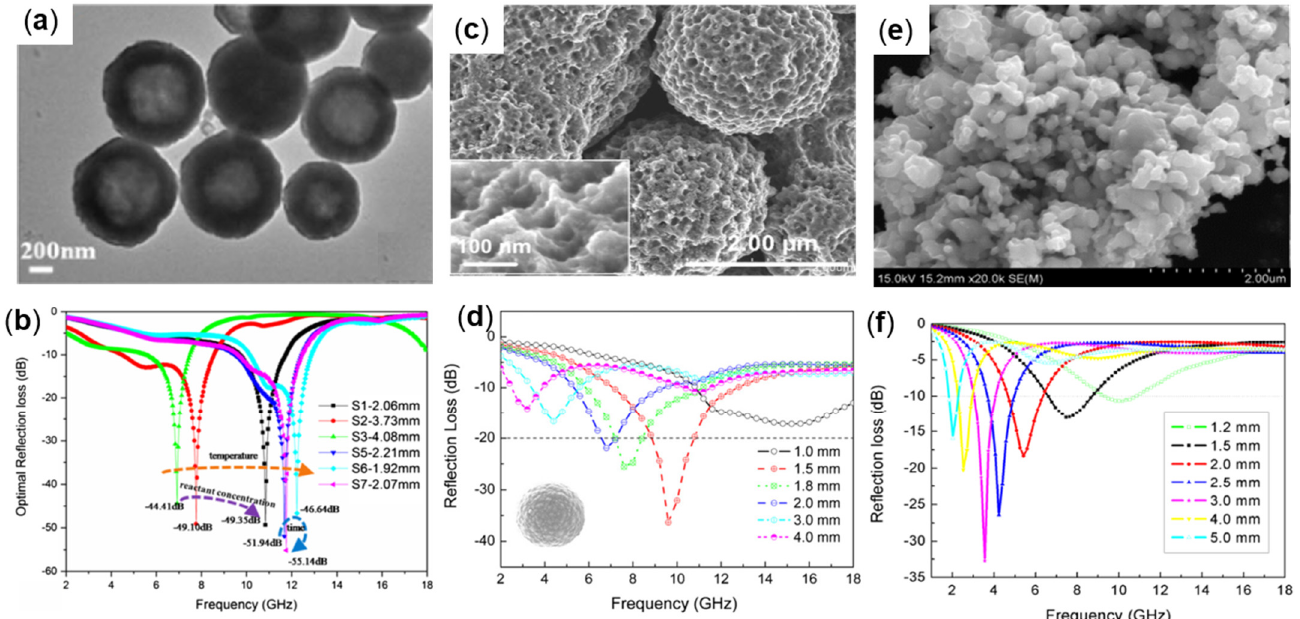
Figure 3. ( a ) SEM and ( b ) RL plot of hollow Fe 3 O 4 , reproduced with permission from Ref. [35], Copyright 2018, Springer Nature. ( c ) SEM and ( d ) RL plot of PIPs, reproduced with permission from Ref. [38], Copyright 2012, Elsevier. ( e ) SEM and ( f ) RL plot of hollow iron spiral particles, reproduced with permission from Ref. [40], Copyright 2016, Elsevier.